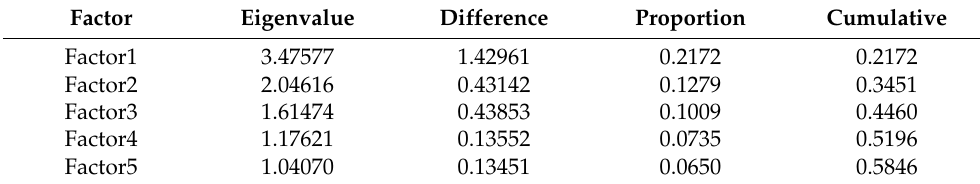
Table 3. Rotated factor loadings and unique variances.